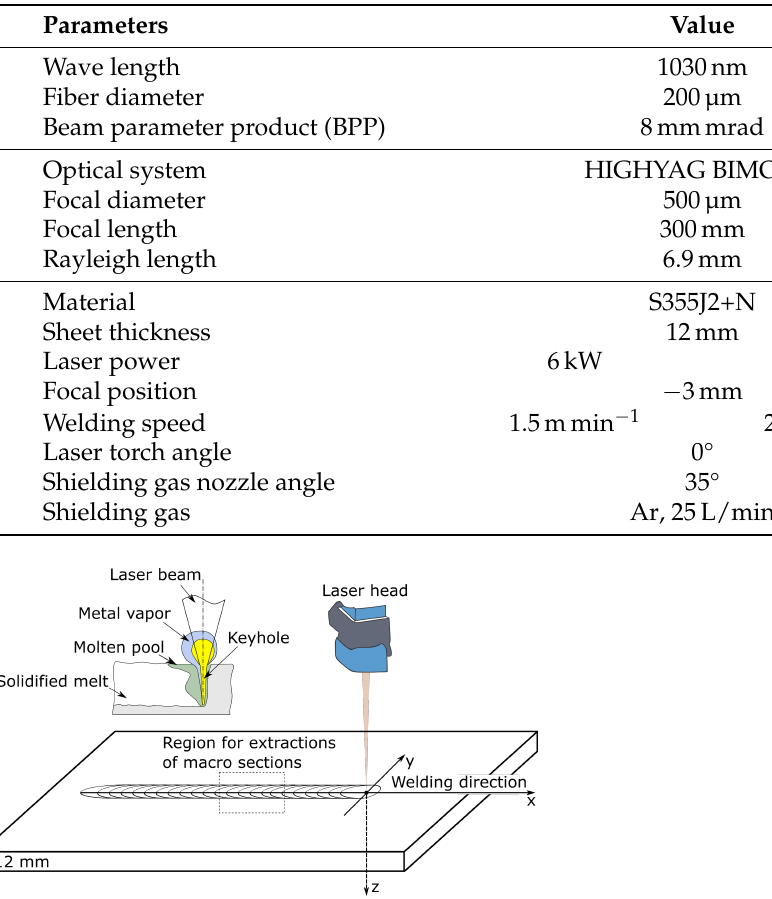
Table 2. Process parameters of the experiments.